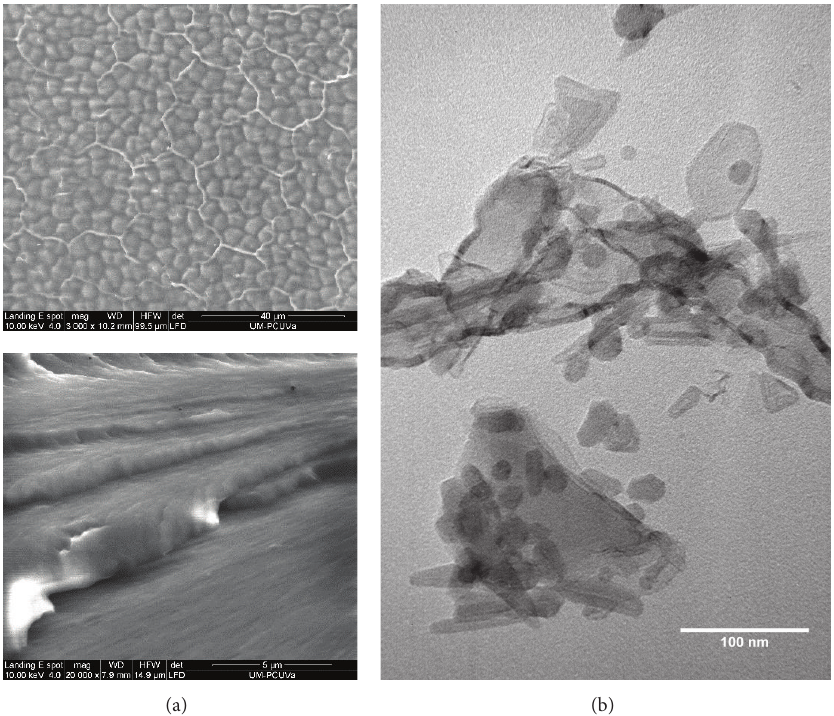
Figure 4: SEM micrographs (a) and TEM micrograph (b) of the ternary chitosan oligomers/propolis/silver NPs composite.